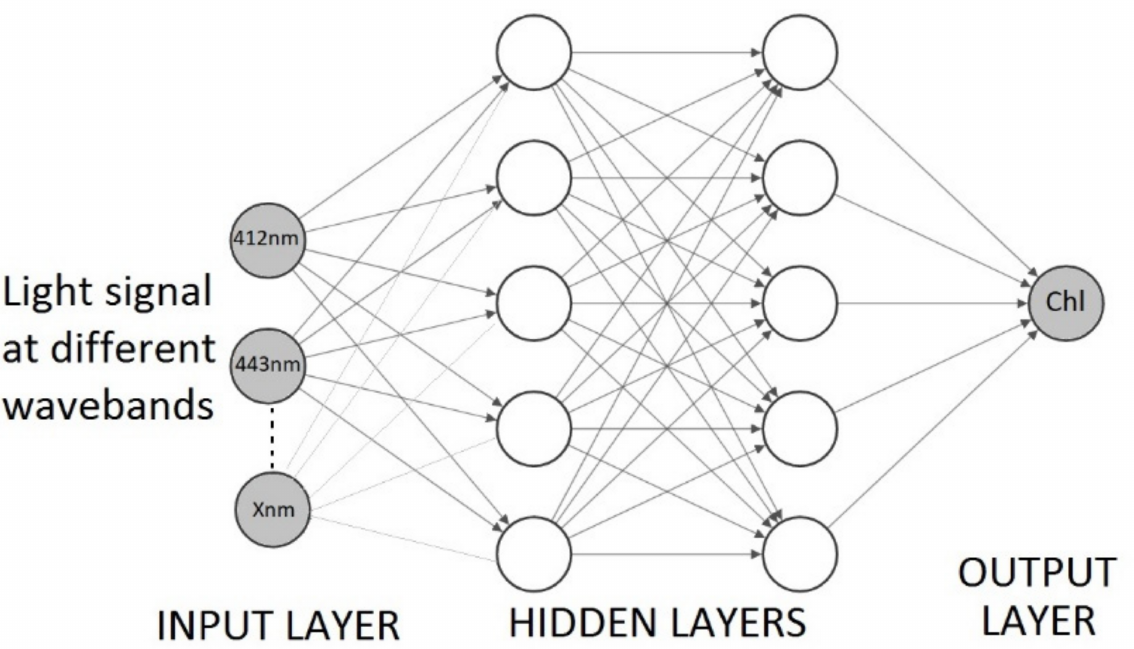
Figure 2. Simplified diagram of a fully connected multilayer perceptron neural network showing, for this example, 2 hidden layers of 5 neurons each. Each arrow is associated to a weight, while the white circles (neurons) apply an activation function. A bias neuron (not shown) is also included for the input and hidden layers and connected to the layer on the right